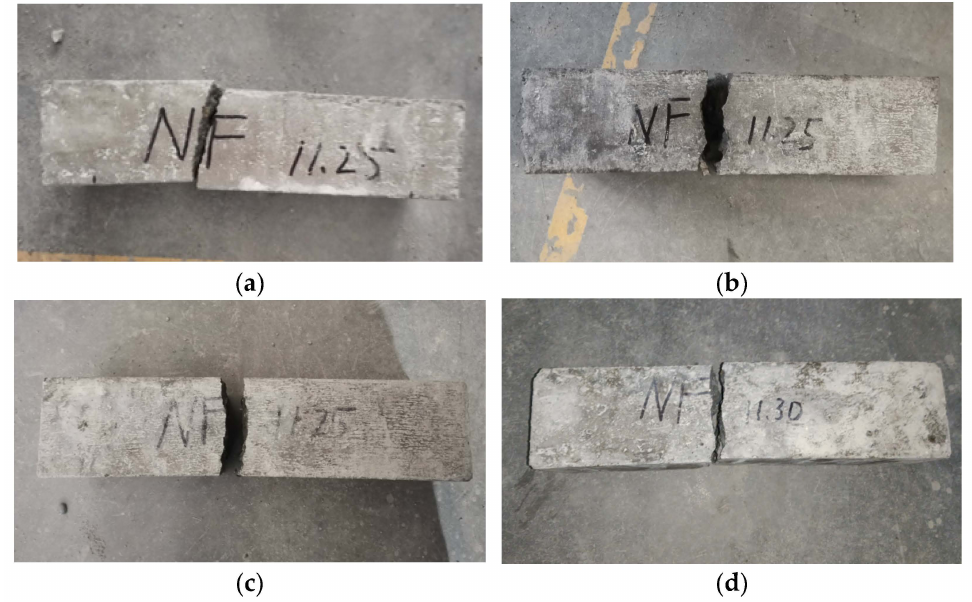
Figure 22. Failure performance of flexural test for NF SWSSC specimens with different ages: ( a ) 3 d; ( b ) 7 d; ( c ) 14 d; ( d ) 28 d.